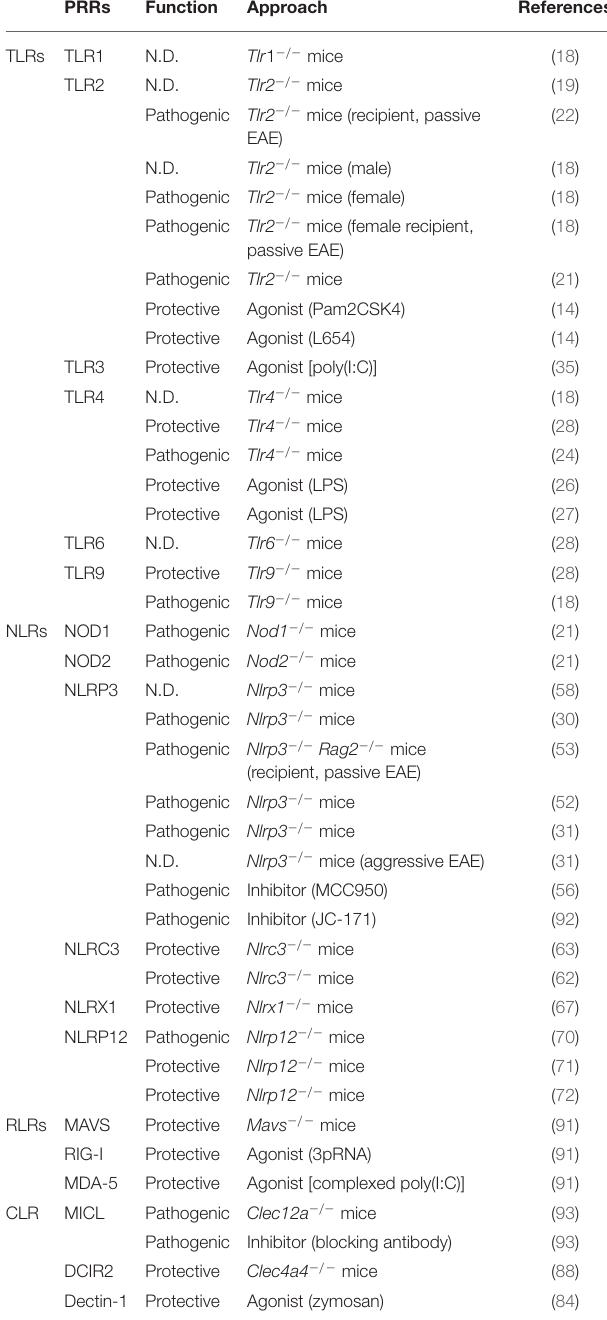
TABLE 1 | Functions of pattern recognition receptors (PRRs) in the EAE model of multiple